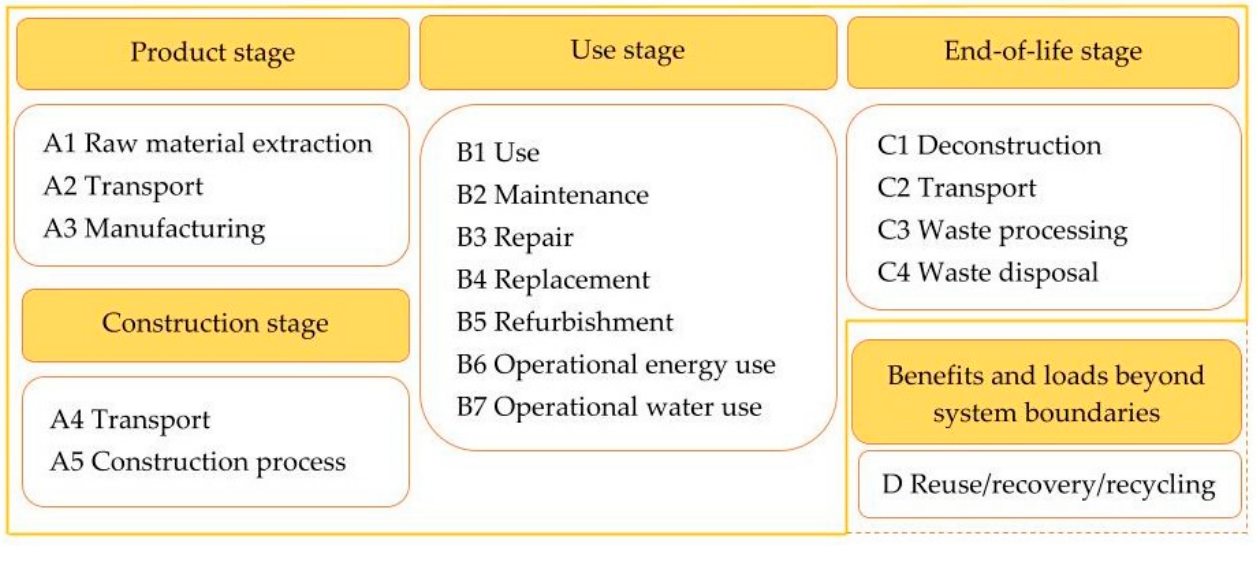
Figure 1. Life cycle stages of buildings.